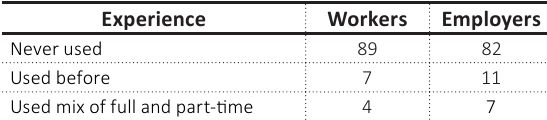
Table 5. Previous experience of online work, %